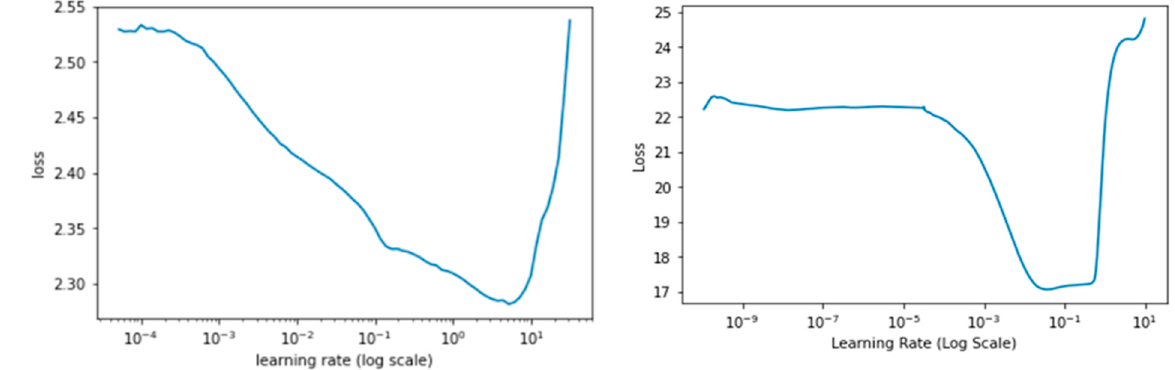
Figure 4. Learning rate range test with the exponential moving average for PlantCLEF 2015 ( Left ) and UBD Botanical datasets ( right ).